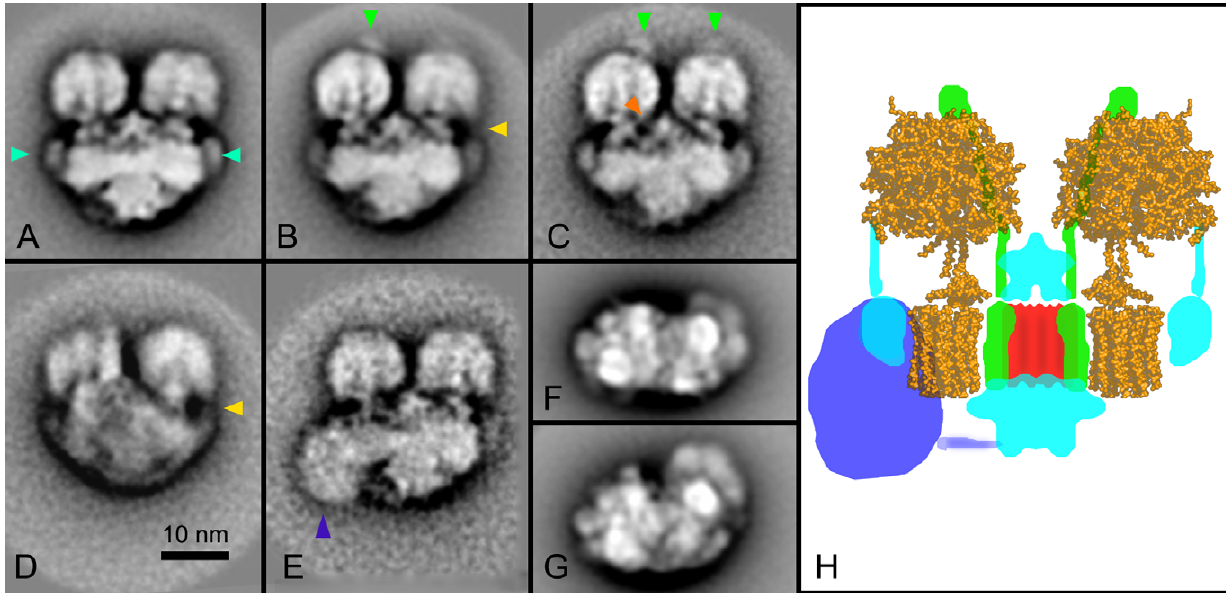
Figure 3. 2-D projection maps of dimeric ATP synthase from Tetrahymenathermophila . (A–E) represent the side view, (F) top view, and (G) intermediate view. The Complexes were extracted either with digitonin (F, G), dodecyl maltoside (A, D, E), or the mixed dataset was used for image analysis (B, C). (E) Dimeric ATP synthase with an additional density next to the c subunit rotor of the left monomer (sum of 64 projections). (H) Interpretation of the projection (B, average of 3,254 projections) with the help of X-ray structure of yeast ATP synthase (PDB accession number 1QO1, [34]). Blue arrowheads (A) mark additional subunits on the extreme left and right positions of the c subunit rotors; green arrowheads (B and C), OSCP subunits; yellow arrowheads (B and D) point to an apparent connection between the domains seen at the extremities of the c rotor (cf., blue arrowheads in (A) and the F 1 headpiece); the orange arrowhead (C), to a connection between the F 1 part and the matrix exposed domain; and the dark blue arrowhead (E) points to an unknown large extra mass attached to F o . The bar represents 10 nm and applies to all